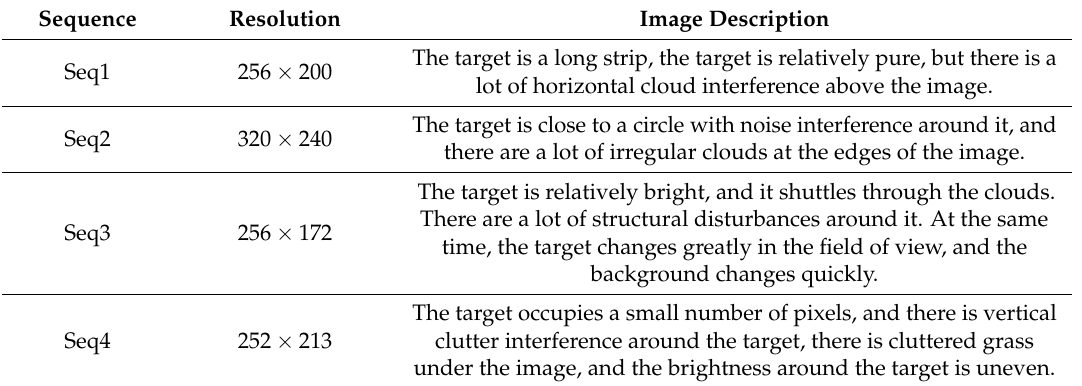
Table 2. Test sequence